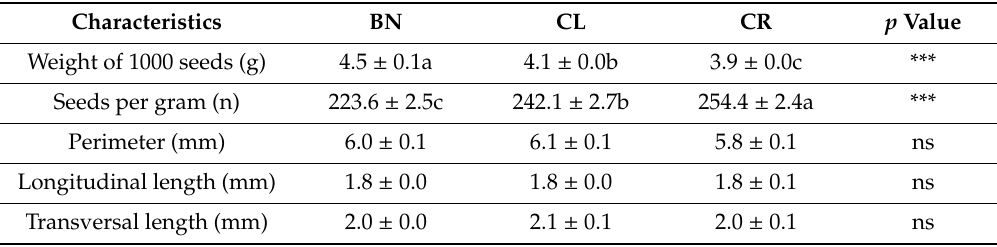
Table 1. Seed morpho-biometric characteristics of ‘Broccolo Nero’ (BN), ‘Cavolo Laciniato Nero di Toscana’ (CL) and ‘Cavolo Broccolo Ramoso Calabrese’